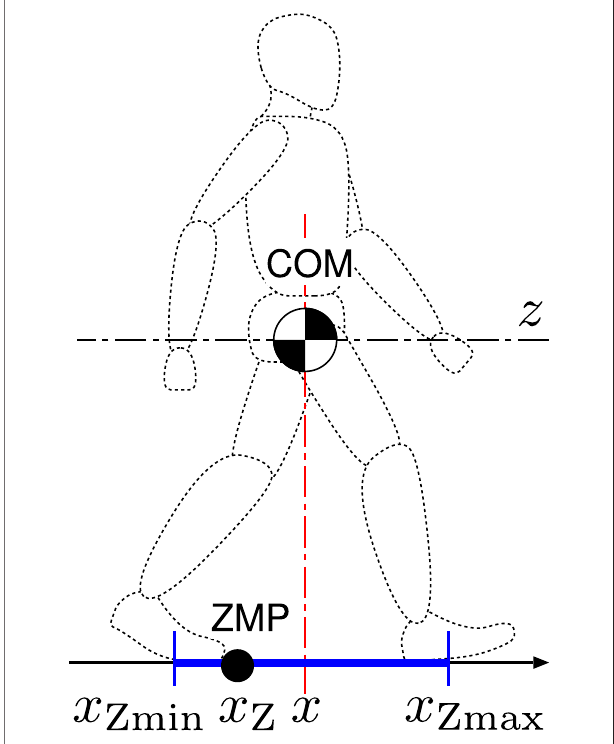
FIGURE 1 | The COM-ZMP model for human dynamics in the sagittal plane. It is additionally assumed that the vertical movement of COM and the inertial torque about COM are negligibly